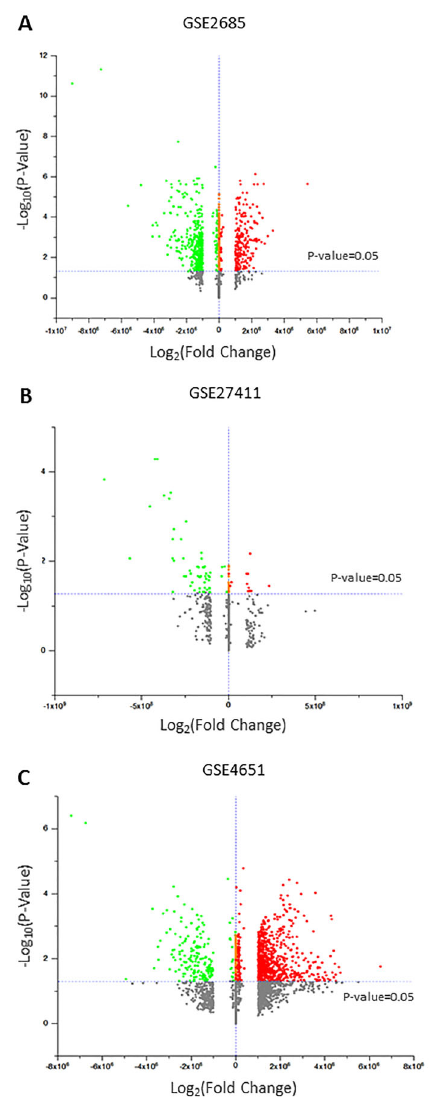
Figure 4. Differentially expressed genes (DEGs) between Gastric Cancer samples and Normal samples. A , The volcano plot for DEGs in GSE2685 data, B , in GSE27411 data, and C , in GSE4651 data. The red dots represent upregulated and the green dots represent downregulated genes, both screened on the basis of j-fold change j 4 1.0, and adjusted of P o 0.05.